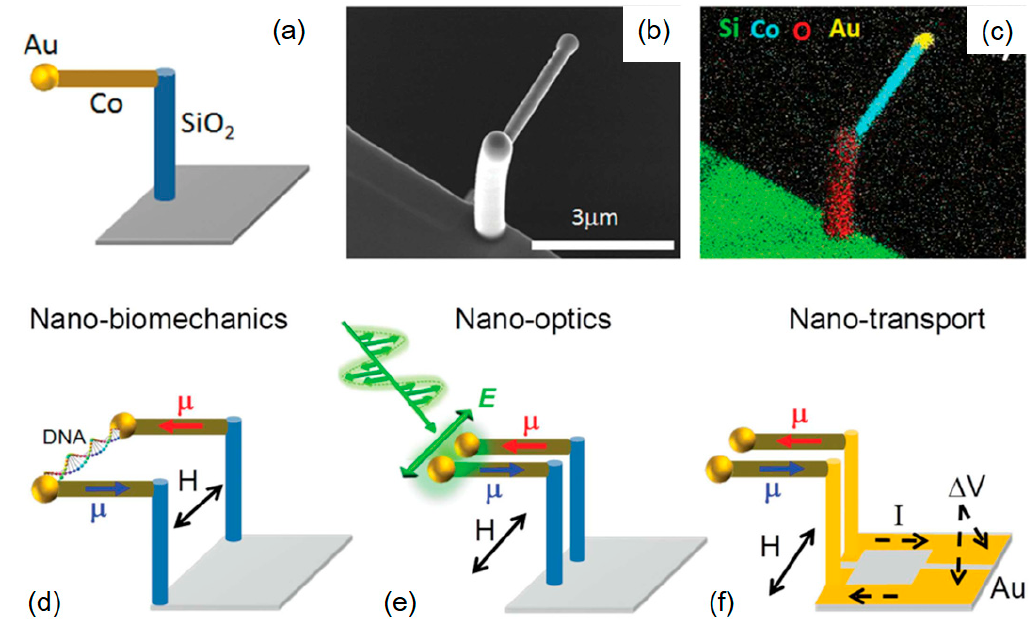
Figure 15. Application possibilities of Au/Co/SiO X multi-material, nanoactuated magnetomechanical systems (NAMMS). ( a ) Basic design of a Co/SiO X NAMMS device, equipped with a small Au sphere at the end of the moving Co cantilever. ( b ) and ( c ) show an SEM image and the correlated energy dispersive X-Ray analysis (EDXS) based elemental map, respectively, which demonstrate FEBID multi-material fabrication capabilities within a single 3D structure. ( d – f ) show potential application examples for correlated analyses concerning magnetic, mechanical, optical, and electrical properties at the nano-scale. Adapted and reprinted from Vavassori et al., Small 2016 [144].